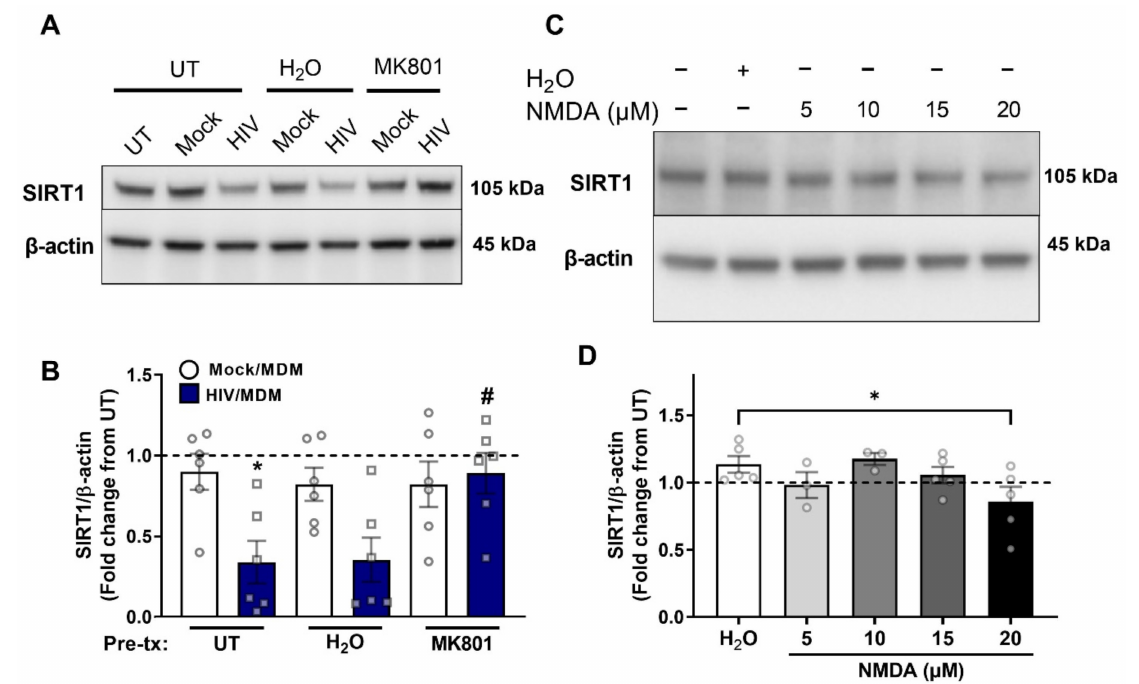
Figure 5. NMDA receptor activation is necessary and sufficient for SIRT1 decrease by HIV/MDMs. Protein lysates were collected from rat neuronal cultures after a 1 h pretreatment with vehicle (H 2 O) or MK-801 and a 16 h treatment with Mock or HIV/MDM supernatants. Representative blots are shown ( A ). Pretreatment with MK-801 rescues SIRT1 levels decreased by HIV/MDMs ( B ). Statistical significance was calculated using two-way ANOVA followed by Tukey’s post hoc. * Represents p < 0.05 compared to Mock/MDMs and # represents p < 0.05 compared to HIV/MDMs ( n = 6). Protein lysates were collected from rat neuronal cultures after 16 h treatment with different concentrations of NMDA or vehicle (H 2 O). Representative blots are shown ( C ). The highest dose of NMDA, 20 µ M, led to a significant decrease in SIRT1 ( D ). Statistical significance was calculated using one-way ANOVA. * Represents p < 0.05 ( n = 3–5). Dotted line represents untreated